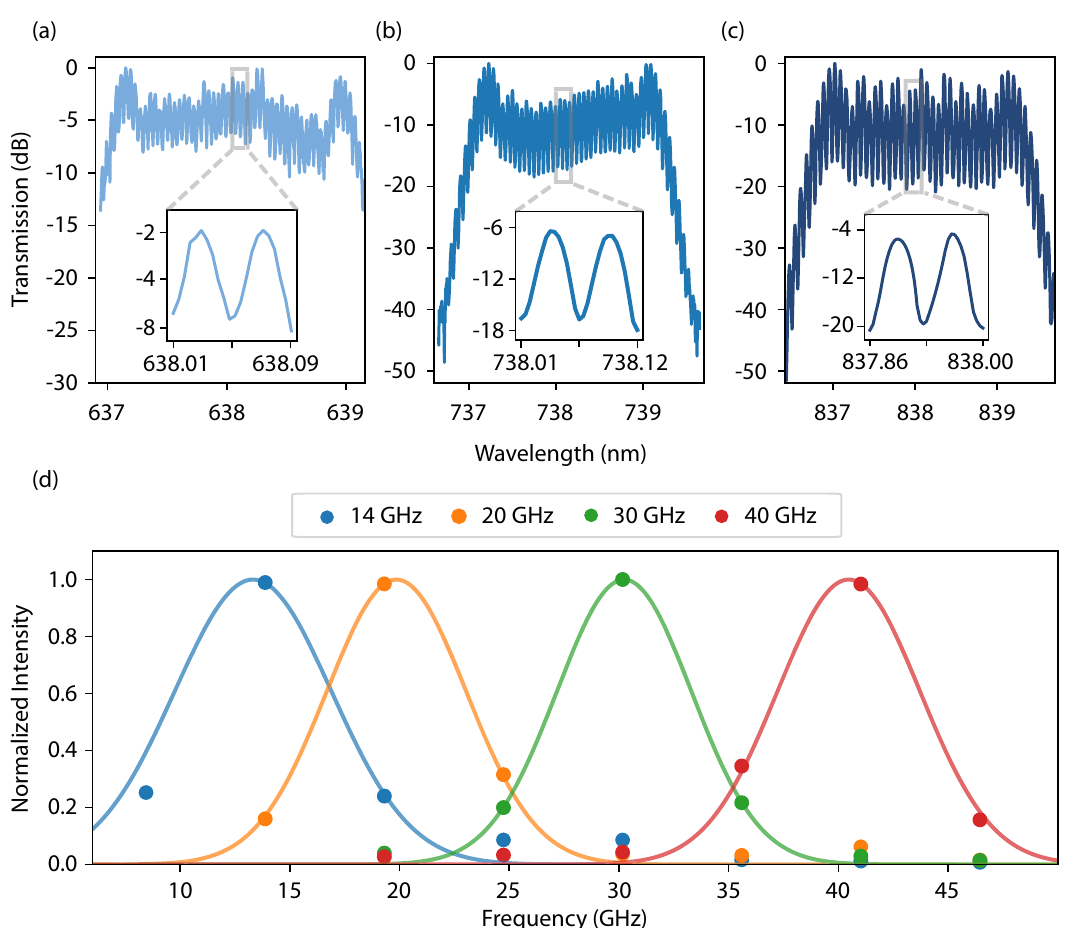
Fig. 3 | Integrated visible-to-near-infrared electro-optic frequency combs. Tunable frequency combs operating at a , λ =638, b 738nm, and c 838nm with 30GHz spacing and more than 50 lines. Insets show magni fi ed view of the comb lines.Theasymmetryshowninthe638nmand738nmcombsisattributabletothe waveguide supporting higher order modes at shorter wavelengths (see